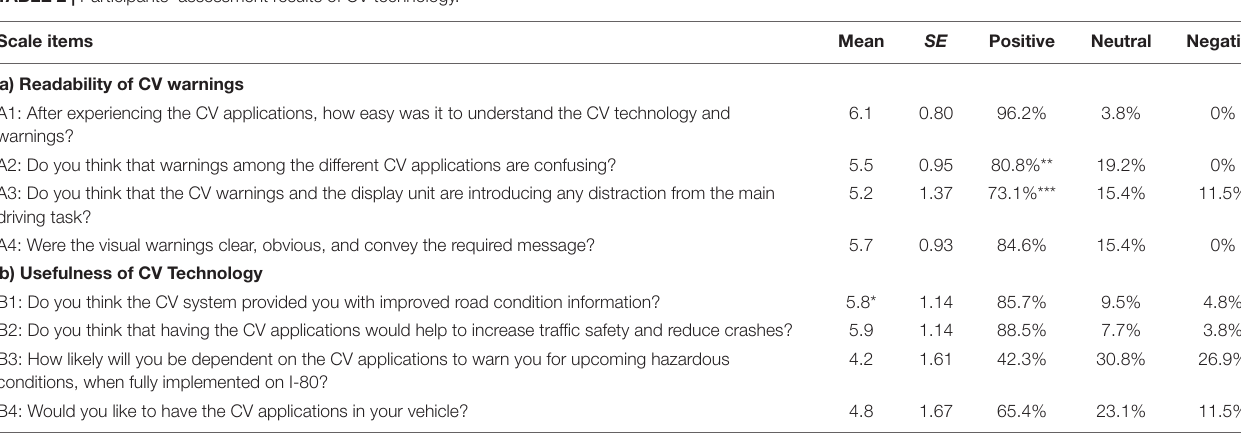
TABLE 2 | Participants’ assessment results of CV